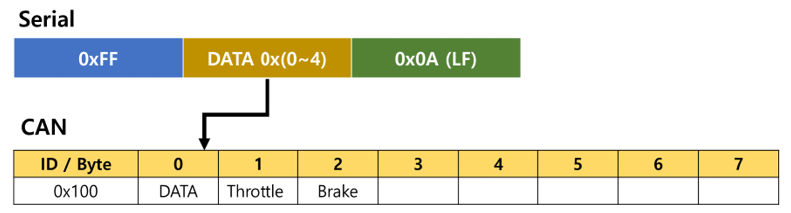
Figure 4. Communication frame for driver assistance systems.